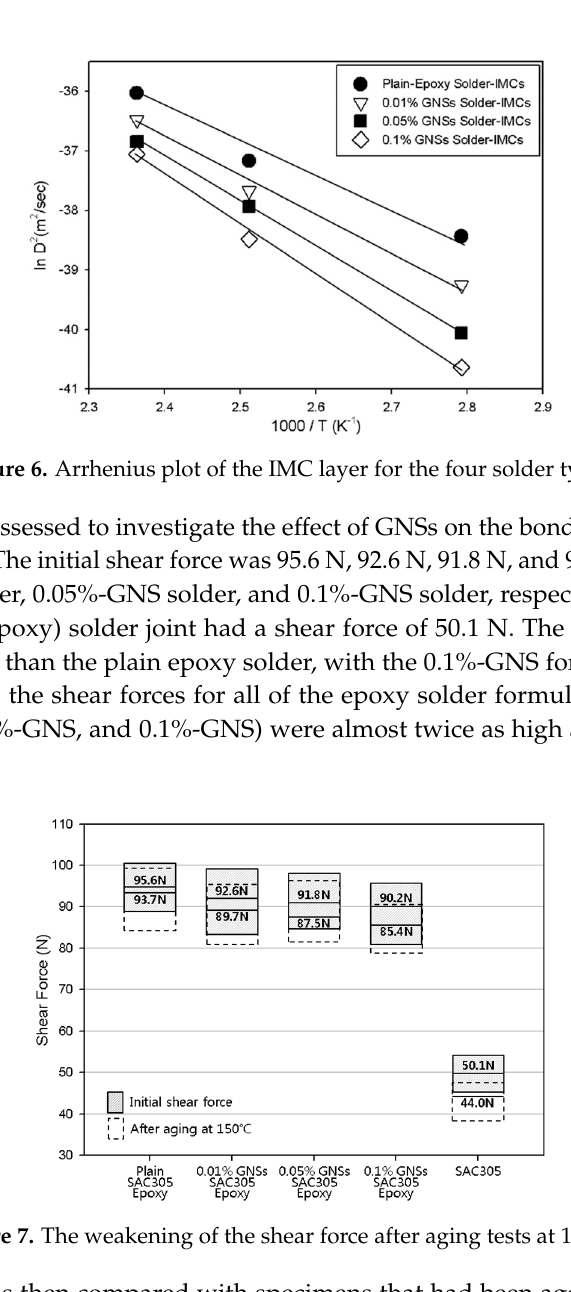
Figure 7. The weakening of the shear force after aging tests at 150 °C.